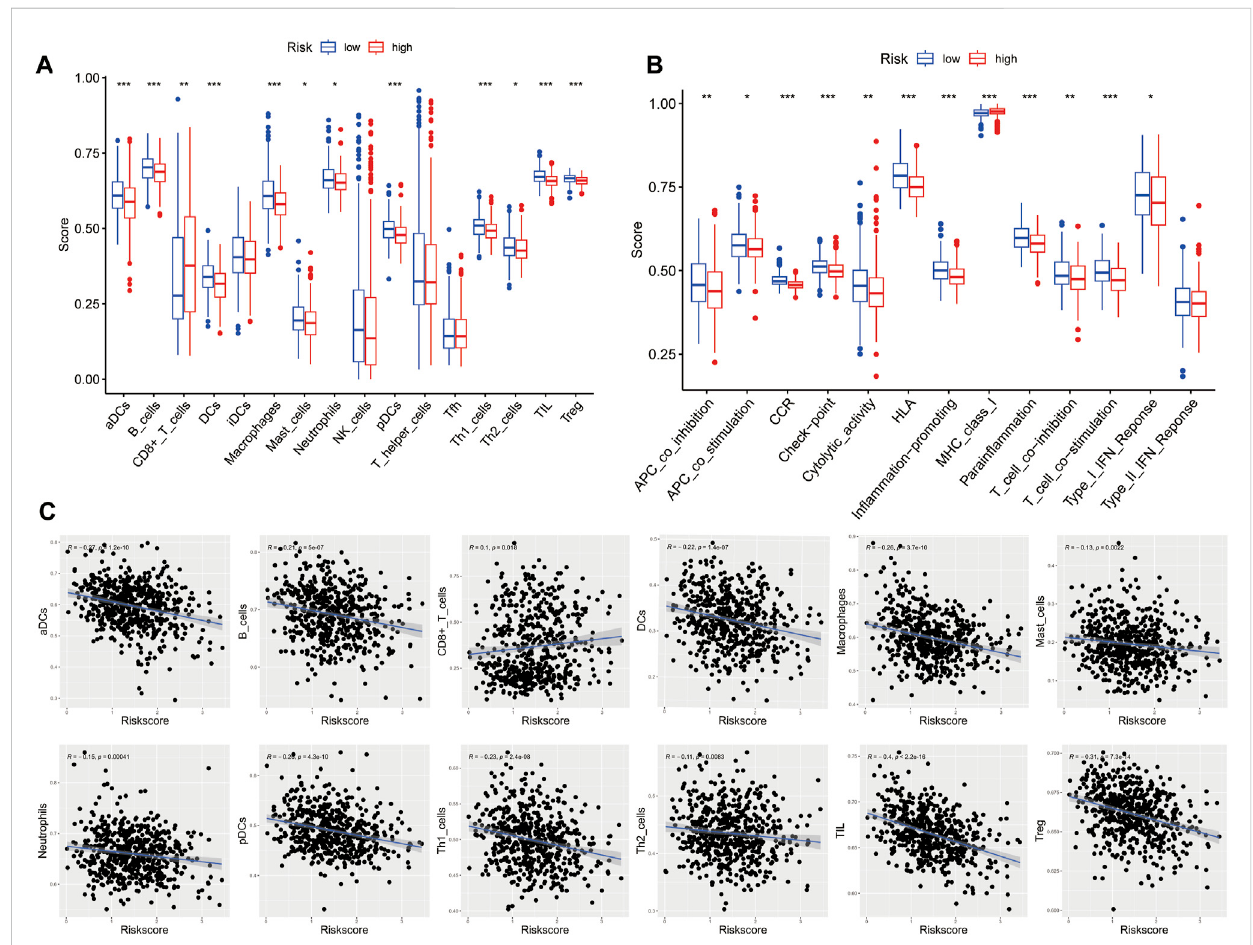
FIGURE 9 Characteristics of immune cell and immune function in different risk groups. (A) Comparison of the 16 immune cell scores calculated by ssGSEA between different risk groups. (B) Comparison of the 13 immune-related functions by ssGSEA between different risk groups. (C) Relations between immune cells and the risk score (* p < 0.05; ** p < 0.01; *** p <